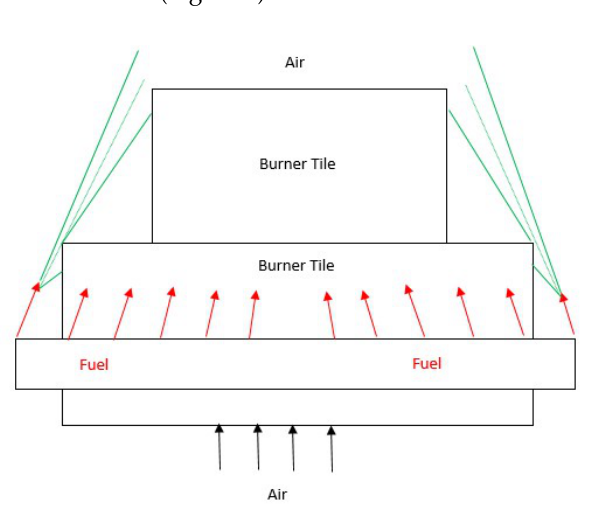
Figure 5. Burner type 1 schematic.